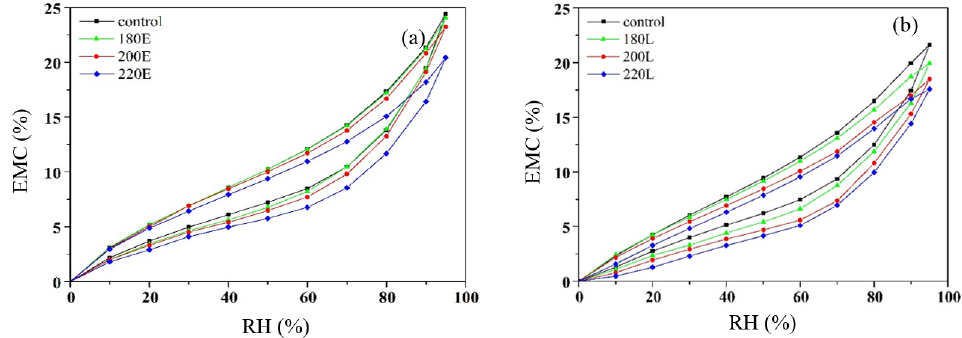
Figure 3. Moisture sorption isotherms of untreated and vacuum heat-treated EW ( a ) and LW ( b ).